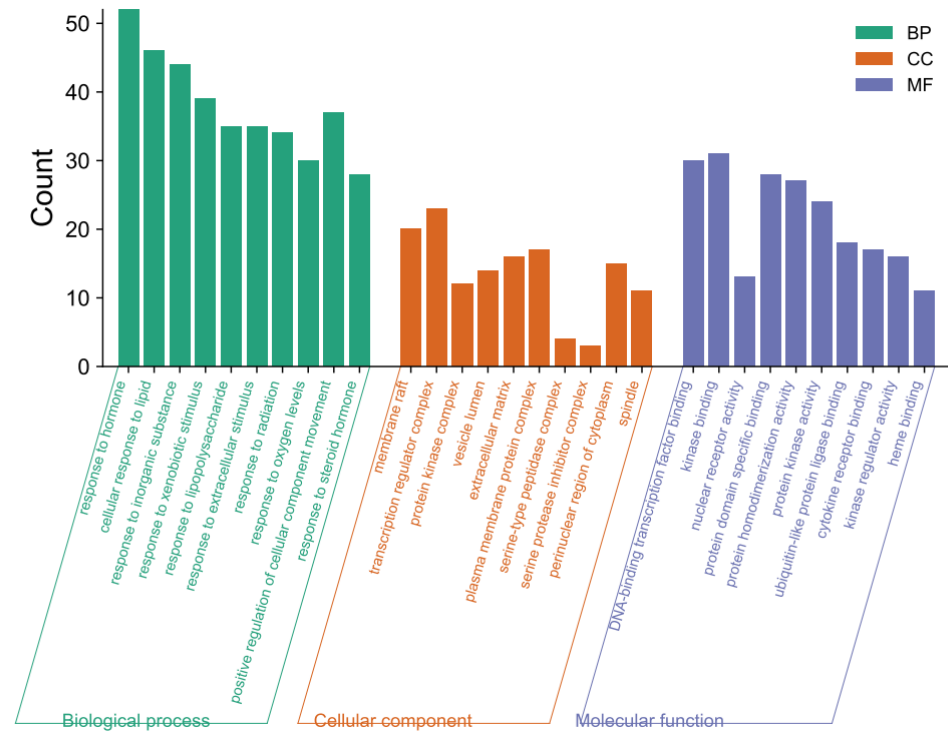
Figure 4. GO enrichment analysis